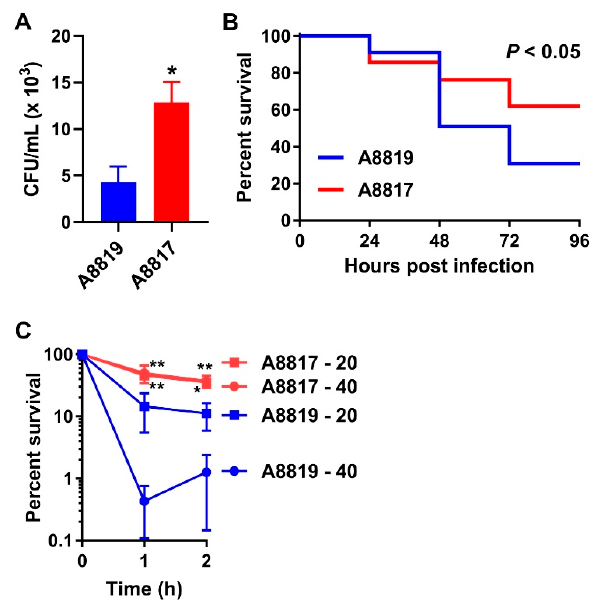
Figure 1. Impact of daptomycin resistance on in vivo virulence and host immune responses. ( A ) Sur- vival of the clinical DAP-R isolate A8817 and its parental DAP-S strain A8819 over 3 h in human blood ( n = 4; * p < 0.05, Mann–Whitney test). ( B ) Survival of zebrafish following bloodstream infection with live S. aureus isolates ( n = 30 embryos, three biological replicates; P value is a comparison of A8819 and A8817 by log-rank test). ( C ) Survival of the clinical DAP-R isolate A8817 and its parental DAP-S strain A8819 over 2 h in the presence of 20 µ g/mL and 40 µ g/mL hNP-1 ( n = 3; for A8817 versus A8819, * p < 0.05 and ** p < 0.01 at indicated time points for same dosages, Student’s t -tests). Error bars represent the mean ± SEM. hNP-1: human neutrophil peptide 1.